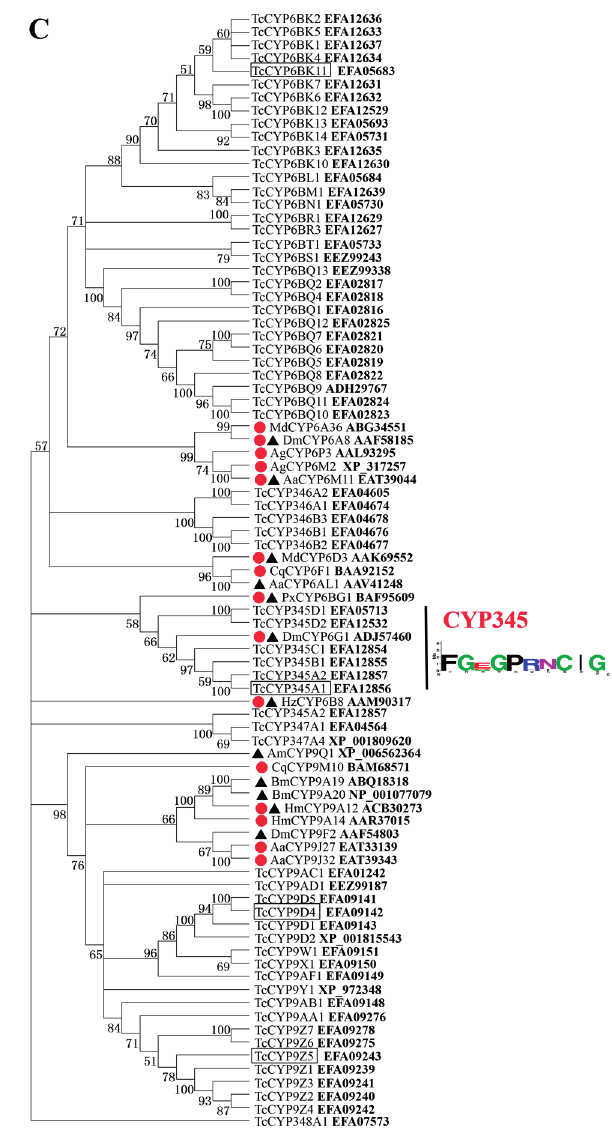
Figure 1. Neighbor-joining phylogenetic trees of three CYP clans. ( A ) mitochondrial; ( B ) CYP4; and ( C ) CYP3. The trees were constructed by using MEGA 5 based on the full-length amino acid sequences deduced from the cDNA or genomic DNA sequences of T. castaneum (Tc), D. melanogaster (Dm), A. gambiae (Ag), Musca domestica (Md), A. aegypti (Aa), C. pipiens pallens (Cp), C. quinquefasciatus (Cq), Blattella germanica (Bg), Helicoverpa armigera (Ha), Diabrotica virgifera virgifera (Dv), Manduca sexta (Ms), Bombyx mori (Bm), H. Zea (Hz), Plutella xylostella (Px), Chironomus tentans (Ct), and Apis mellifera (Am). The accession number of each gene from NCBI is shown in bold at